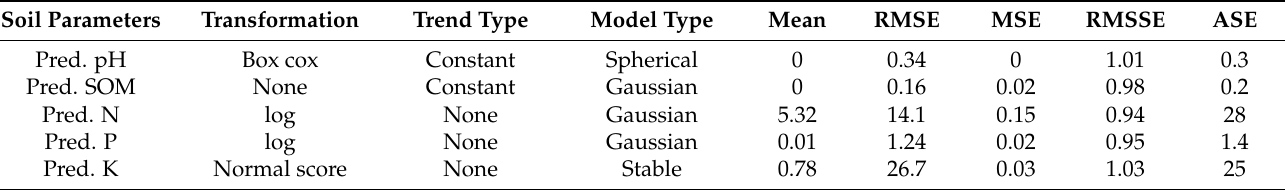
Table 6. Geostatistical OK analysis of predicted soil properties (pH, OM, N, P, and